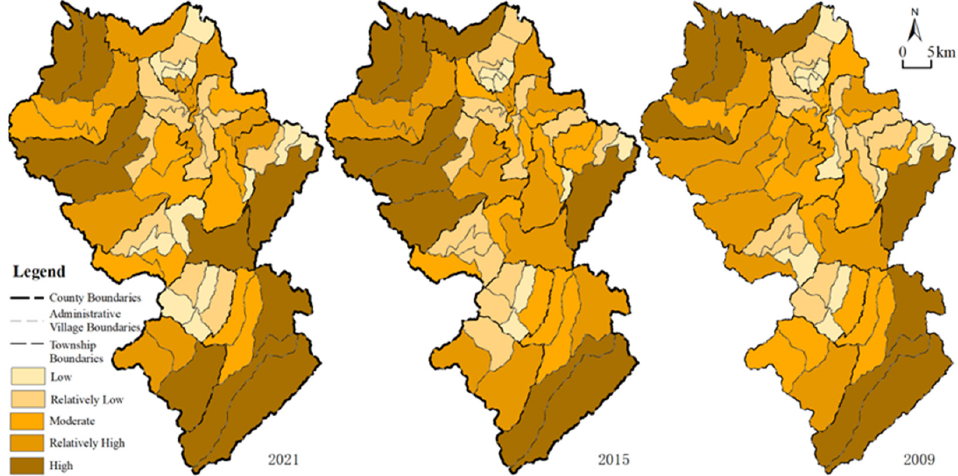
Figure 2. Spatial distribution of land use for rural tourism in 2021, 2015, and 2009.